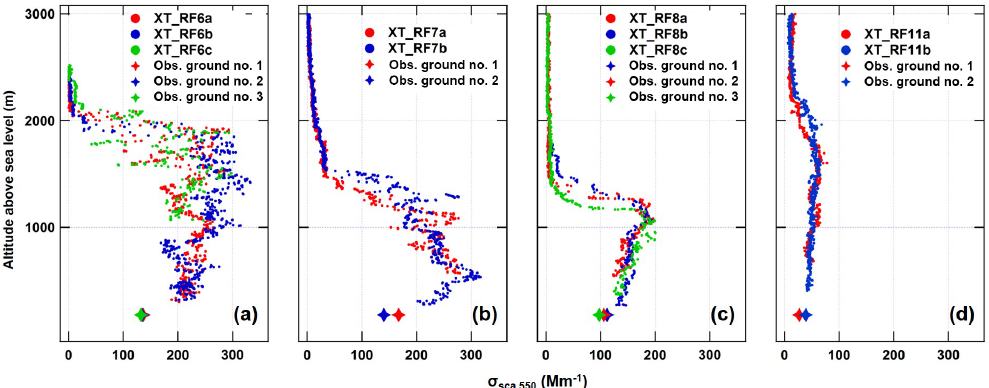
Figure 3. Aircraft-measured vertical profiles (colored circles) and surface CAPS-measured (colored plus symbols) σ ext at 550nm on (a) 21 May (RF6, panels a , b , and c represent spiral up/down), (b) 28 May (RF7), (c) 28 May (RF8), and (d) 11 June (RF11).